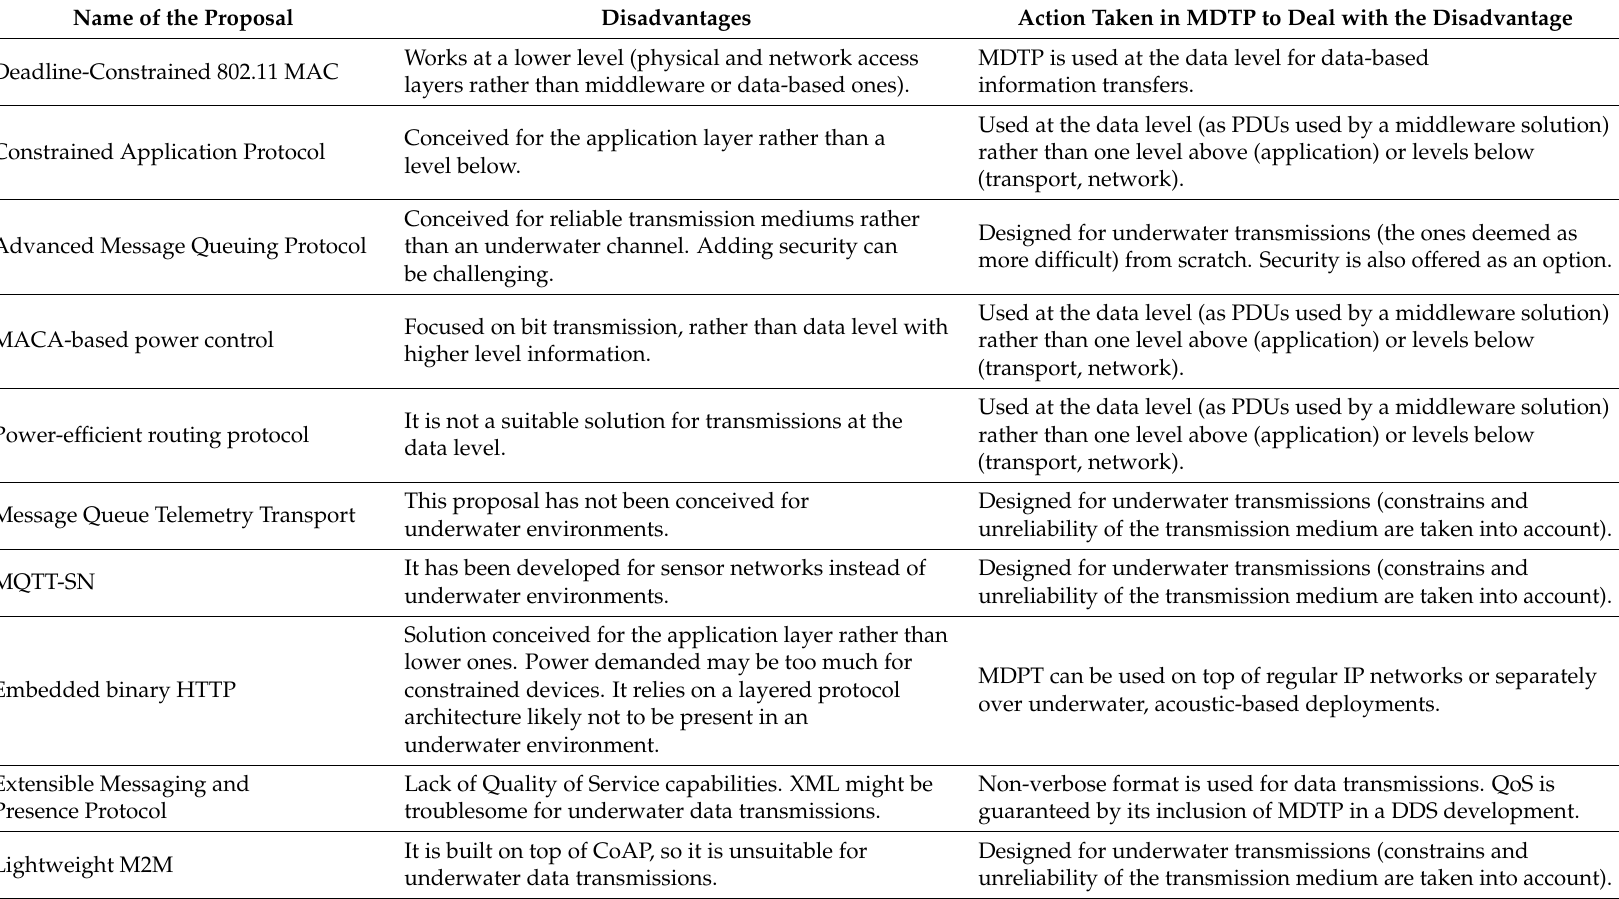
Table 2. Actions taken by